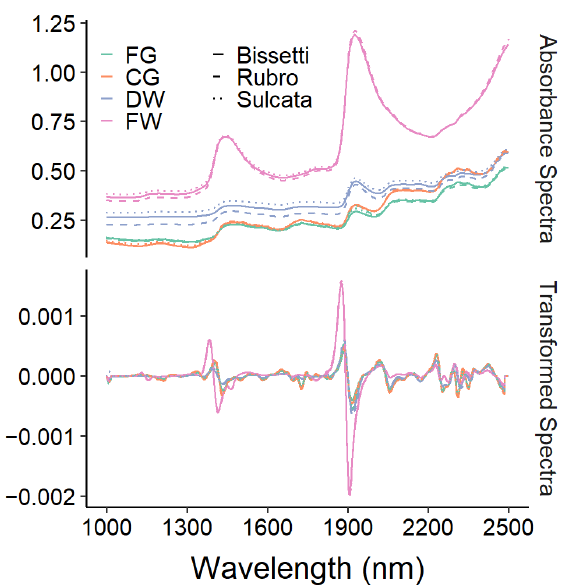
Figure 4. Raw ( up ) and transformed ( down ) spectra from four processing modes, grouped by species. Spectra collected by each processing mode from each species were averaged. Fresh–Whole (FW), Dry–Whole (DW), Coarse–Ground (CG), Fine–Ground (FG).